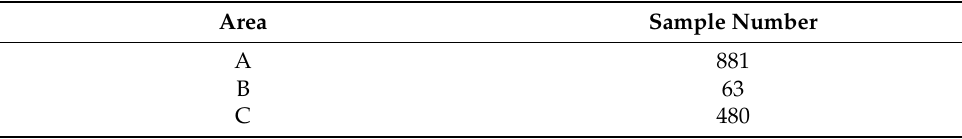
Table 2. Sample numbers of the three